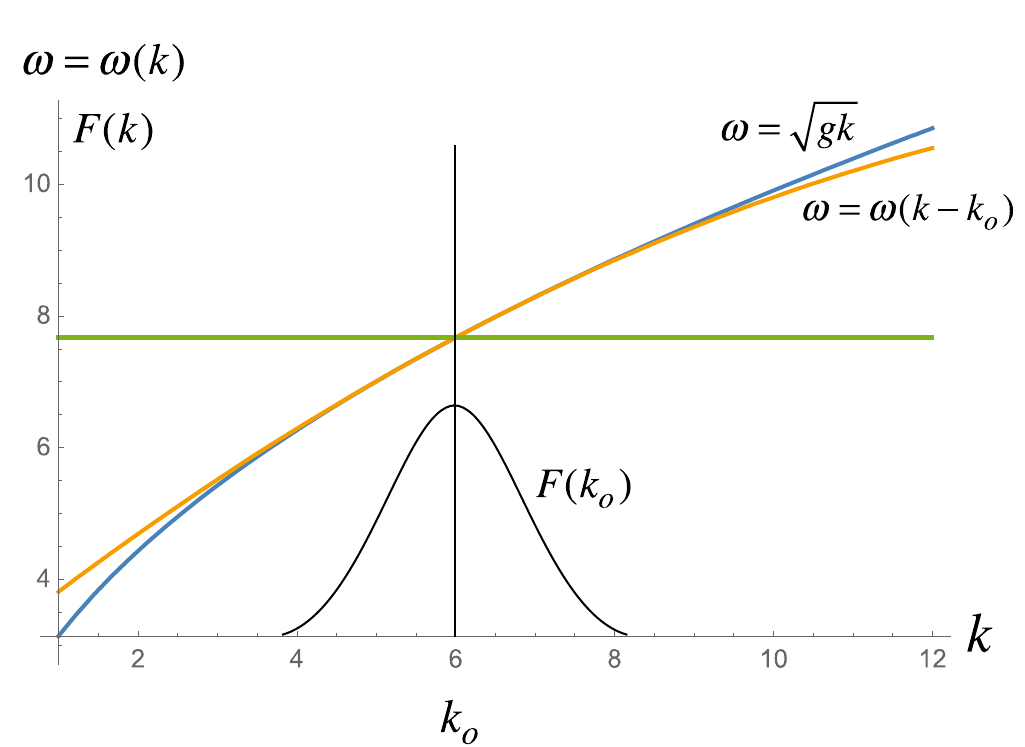
(cid:112) gk , (blue) with the dispersion relation